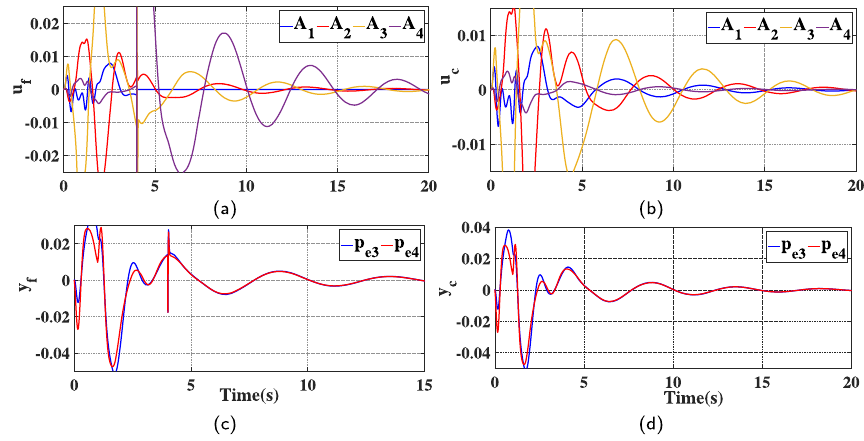
This makes for an autonomous fault tolerant control sys- for an fault tolerant wide area damping controller.